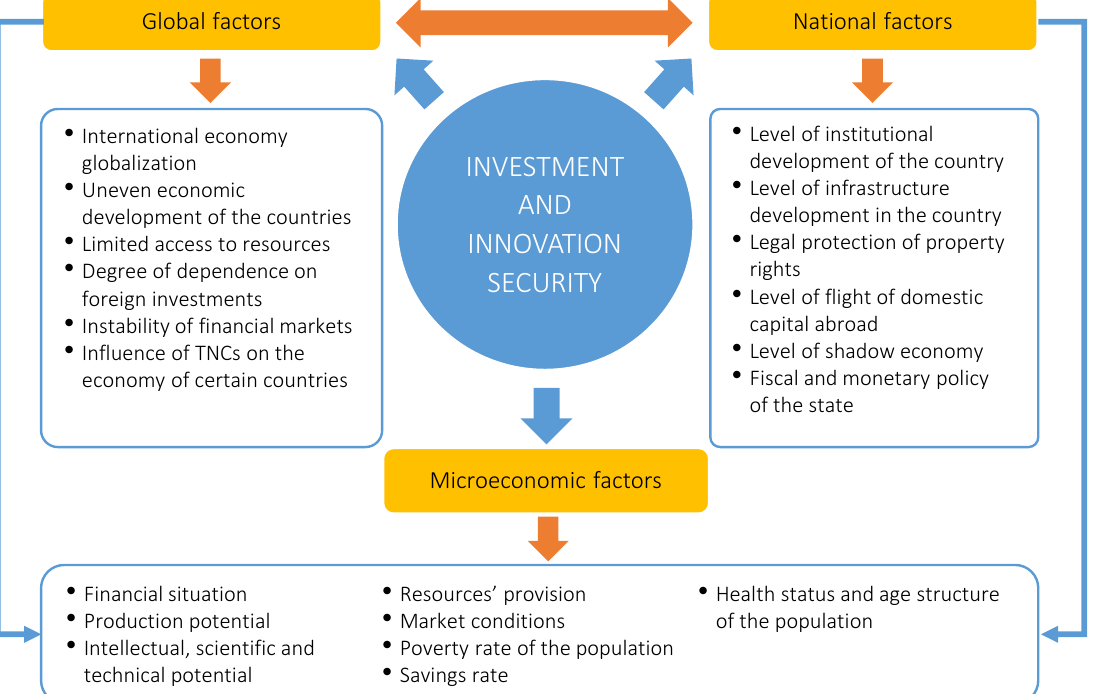
Figure 2. Investment and innovation security